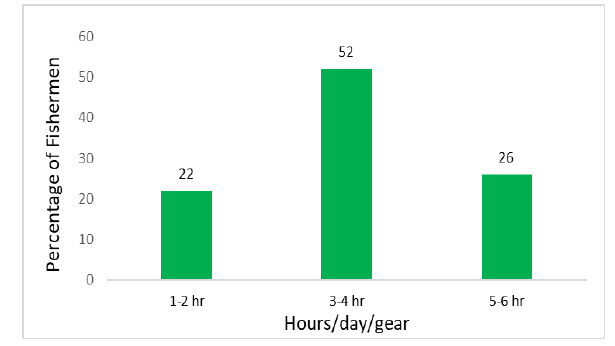
Figure 2: Fishing duration of the fishermen in the study area